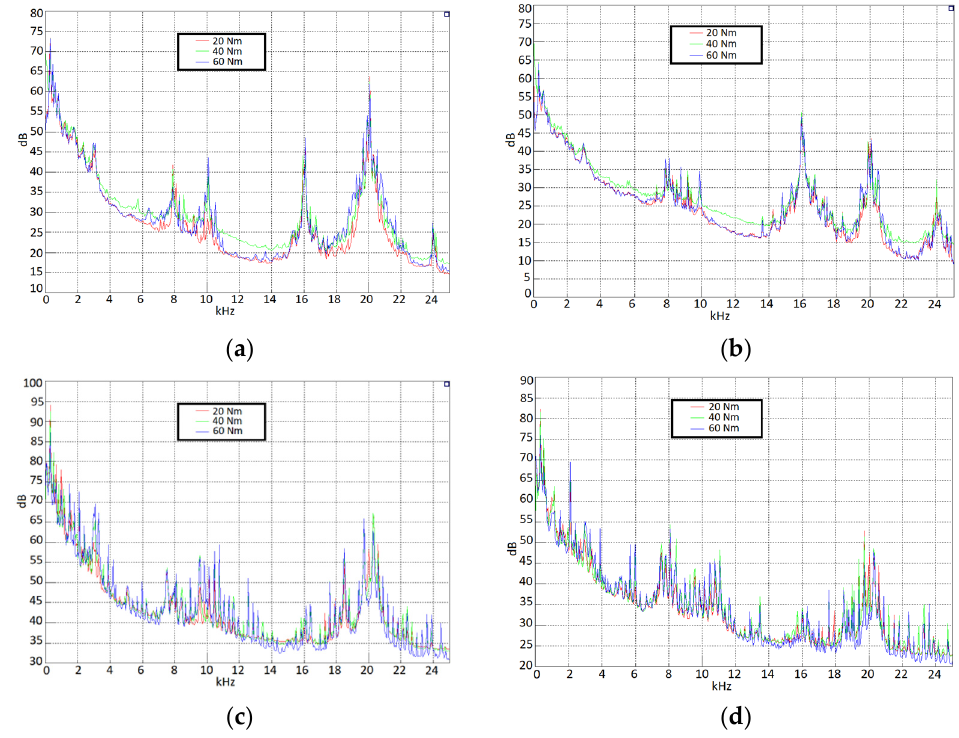
Figure 24. Noise at different rotational speeds at 45 deg current angle: ( a ) 1000 rpm microphone next